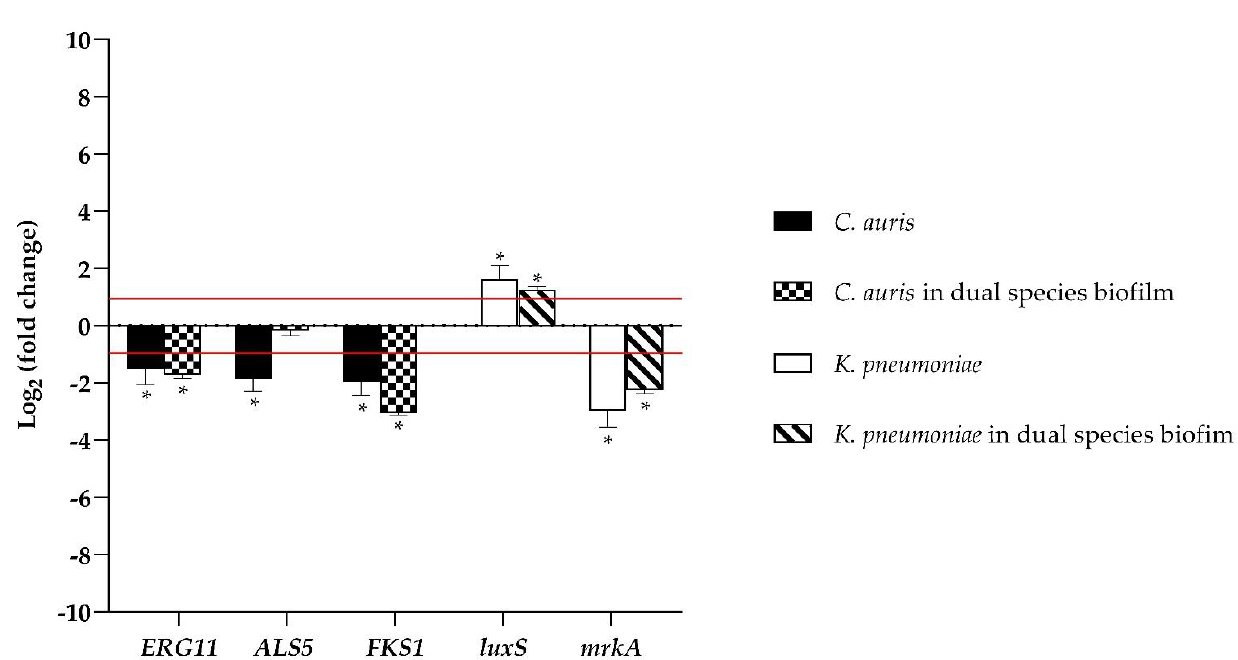
Figure 4. Real-time qPCR at 24 h of treatment with MYR at a concentration of 12.5 µgmL − 1 . Histo- grams show the mean ± SD of relative mRNA expression levels of virulence response genes. Hori- zontal red lines indicate fold change thresholds of 2 and 0.5, respectively. * = p < 0.05 ( t -test).